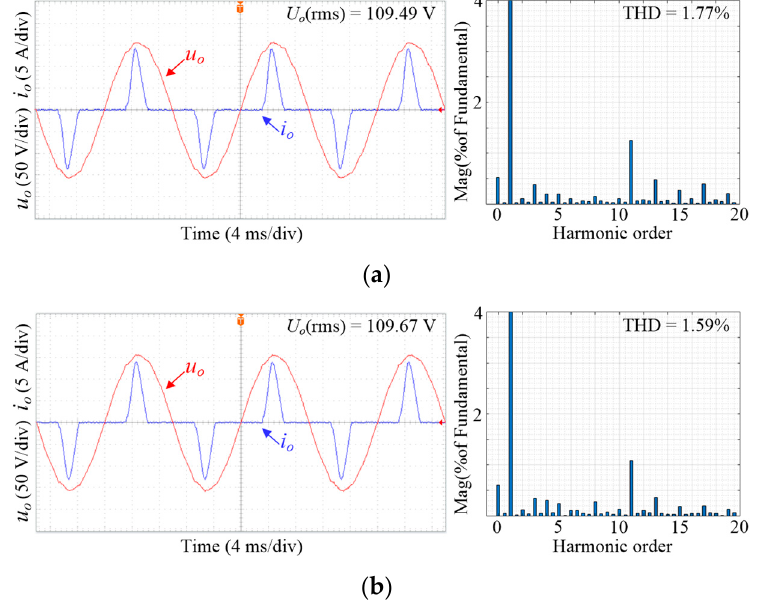
Figure 20. Steady-state waveforms of HC-SRFPI-LADRC with different mismatch factor of L under nonlinear load. ( a ) L A / L = 0.8, ( b ) L A / L = 1.2.